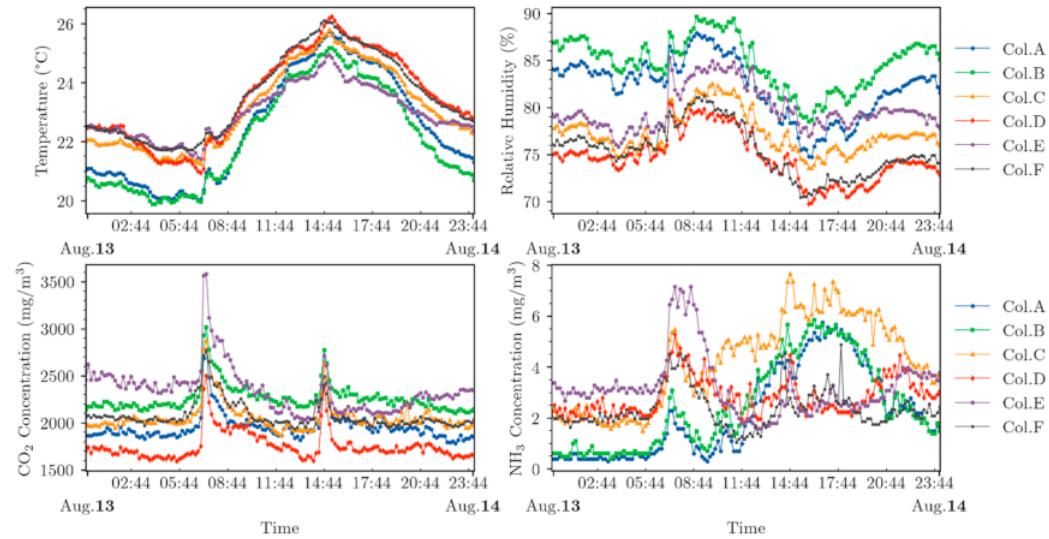
Figure 12. Four environmental parameters recorded by indoor nodes varied from August 13 to August 14.